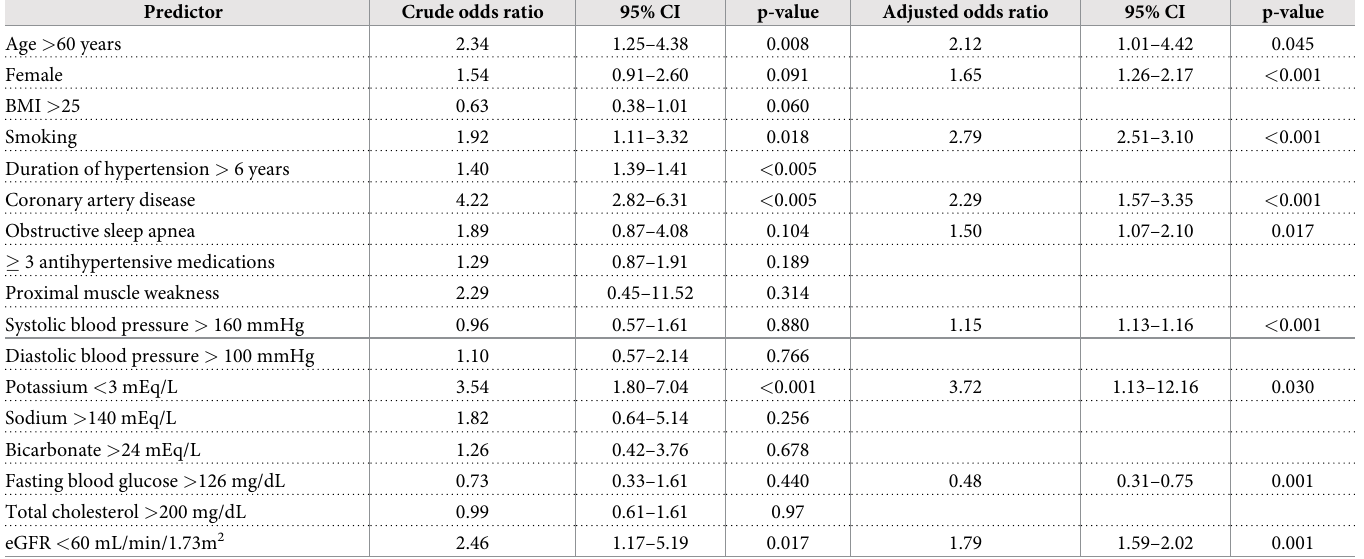
Table 2. Univariable and multivariable logistic regression analyses of predictive factors related to primary aldosteronism.